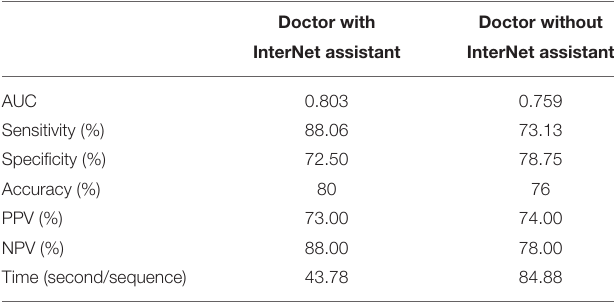
TABLE 3 | Classification performance of a doctor with and without